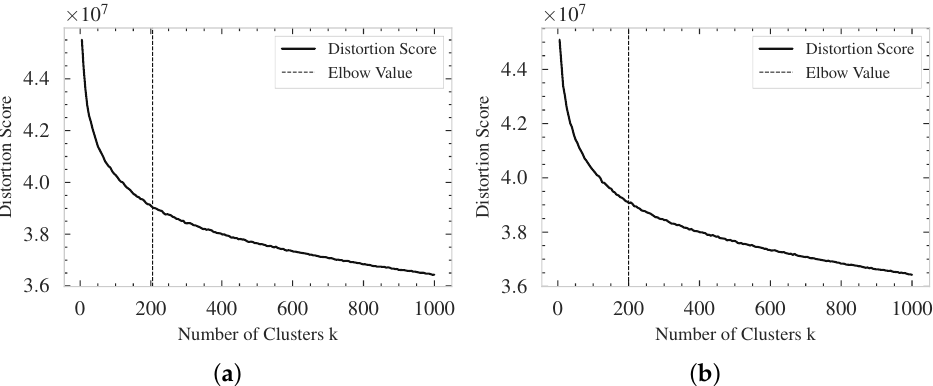
Figure 2. The elbow plots for cross-validation set showing: ( a ) the elbow plot for fire and ( b ) the elbow plot for forest.